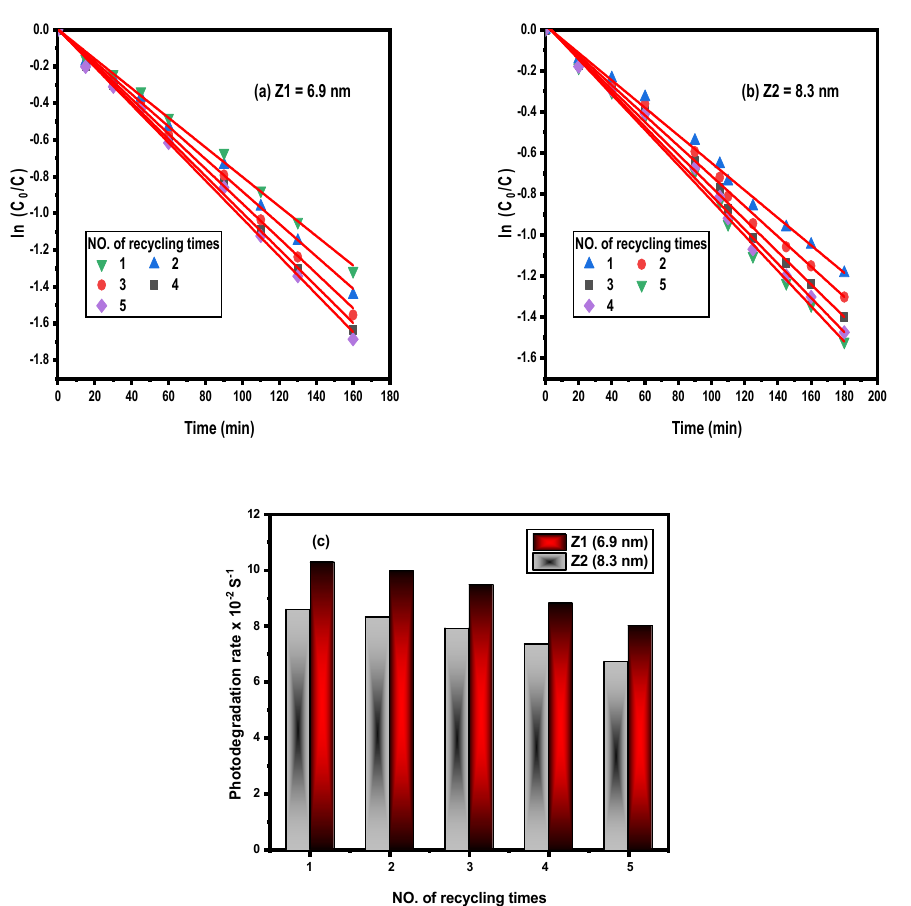
Figure 10. Kinetics plot ( a , b ) and correlation between photodegradation rate of reactive yellow dye and no. of recycling processes by using different prepared ZQDs samples ( c ).